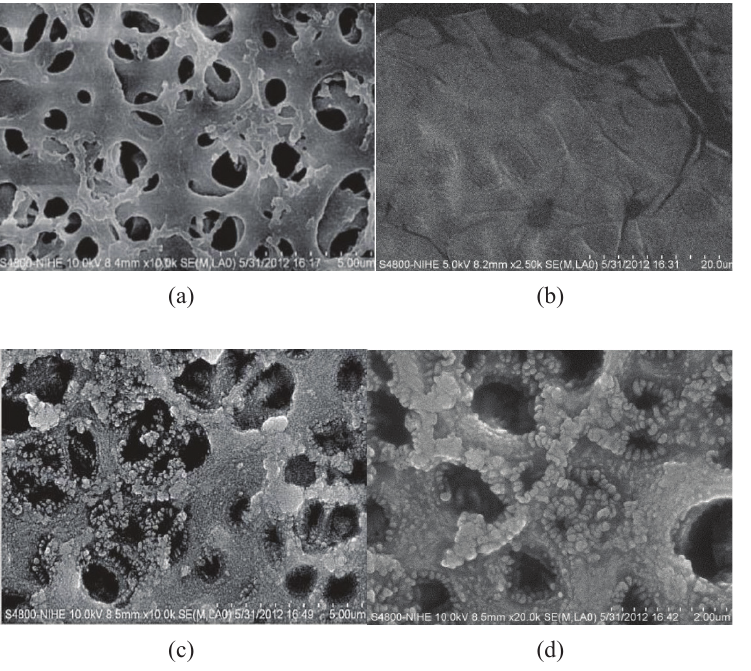
Table 5 – Differential pressure between feed compartment and permeate compartment